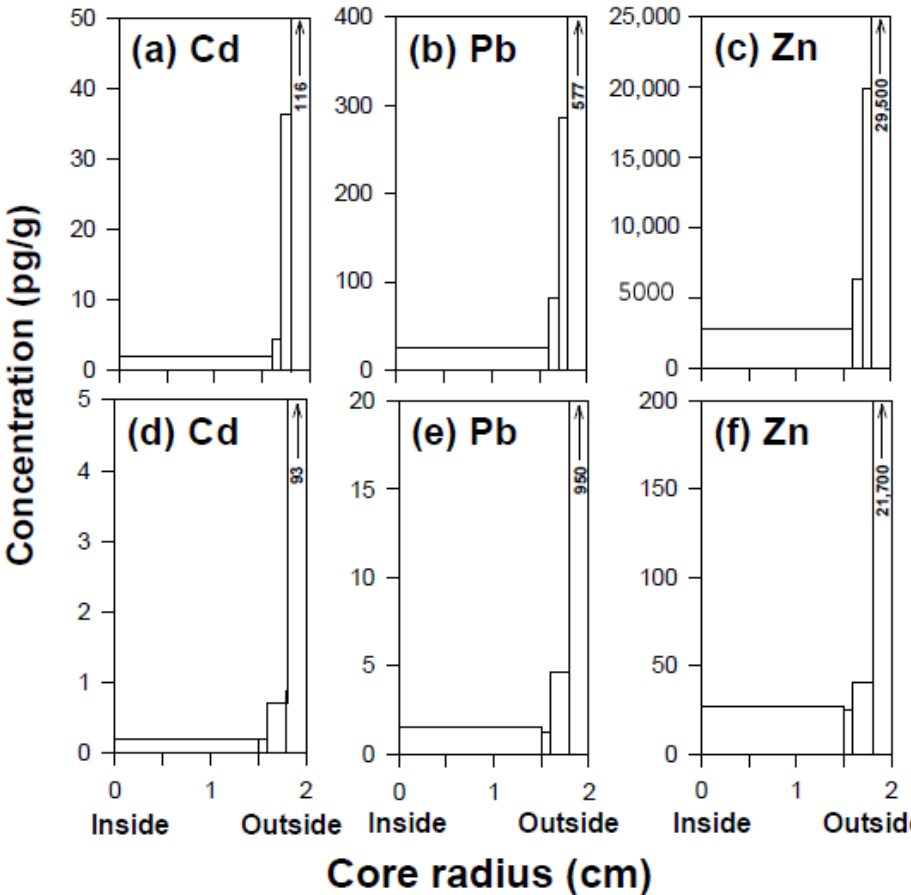
Figure 2. Examples of changes in Pb and Zn concentrations as a function of radius in two sections.